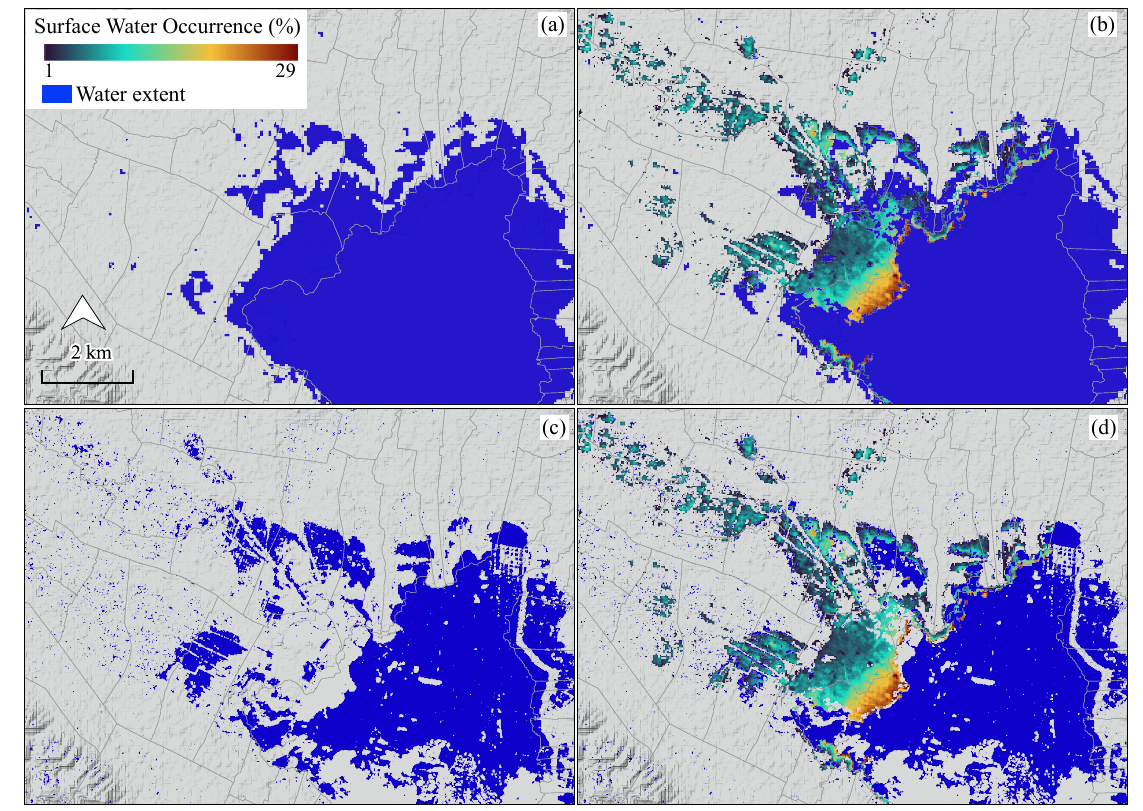
Figure 10. ( a ) Water extents (23 May 1978) extracted by the Landsat; ( b ) overlay of surface water occurrence on ( a ); ( c ) water extents (7 December 2021) extracted by the Sentinel-1; ( d ) overlay of surface water occurrence on ( c